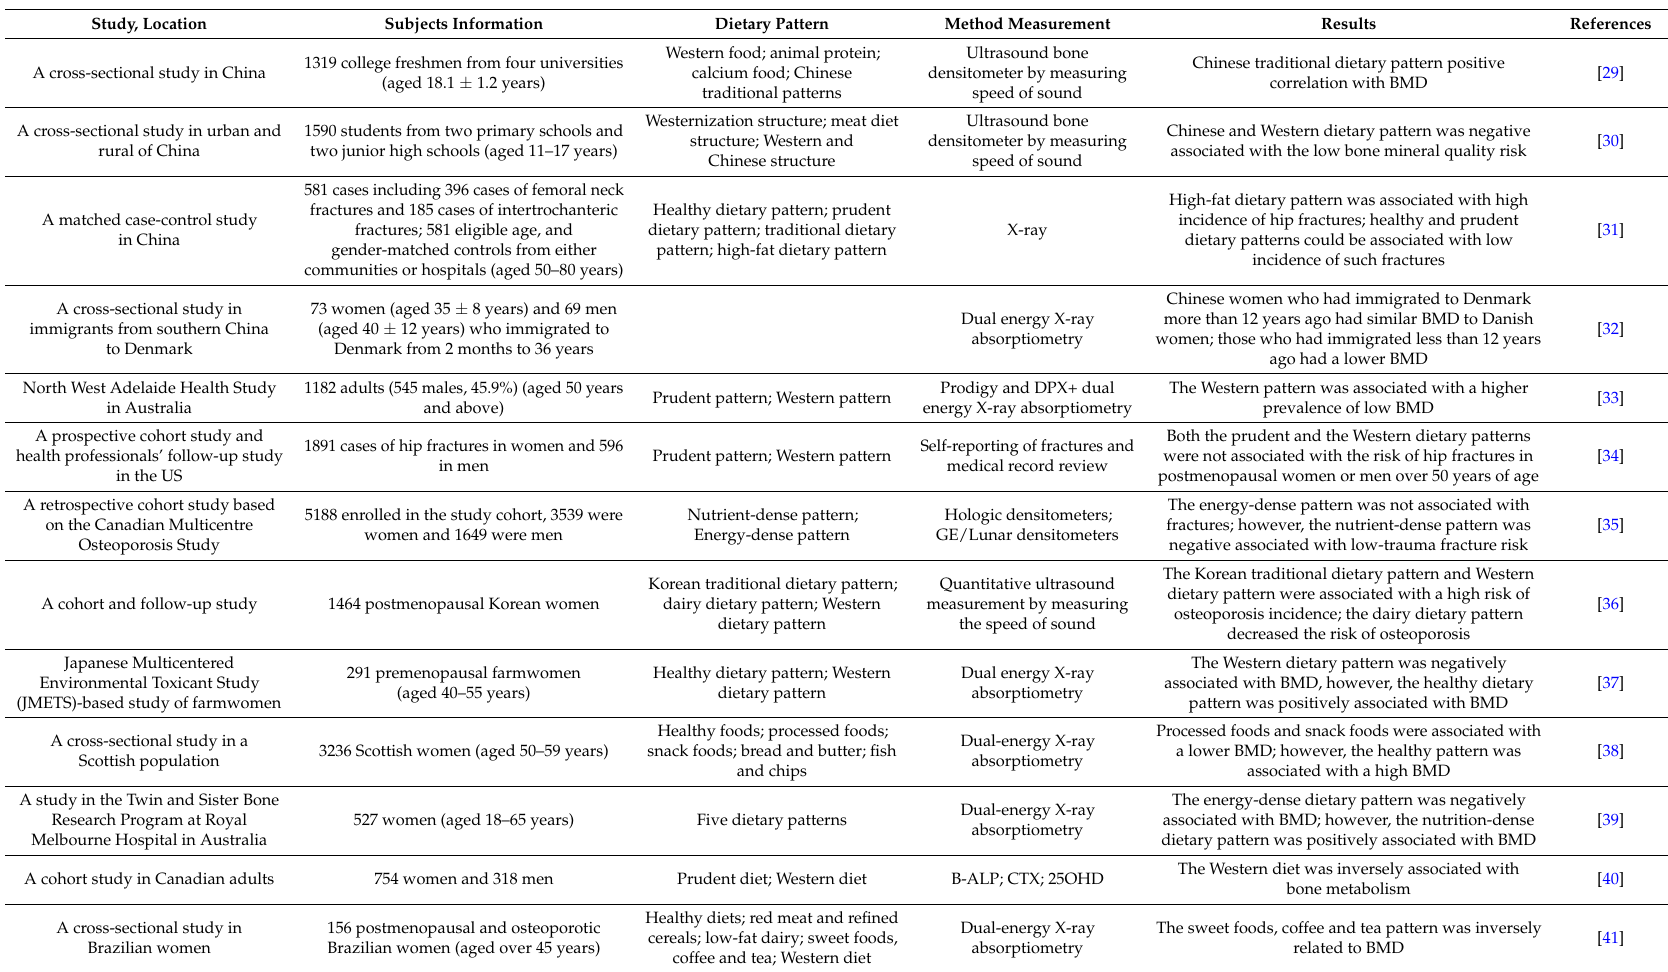
Table 3. Different dietary patterns and bone health in human